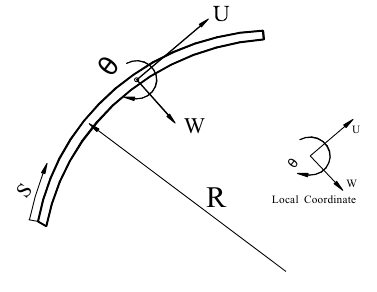
Fig. 1. Components of displacement in a typical curved